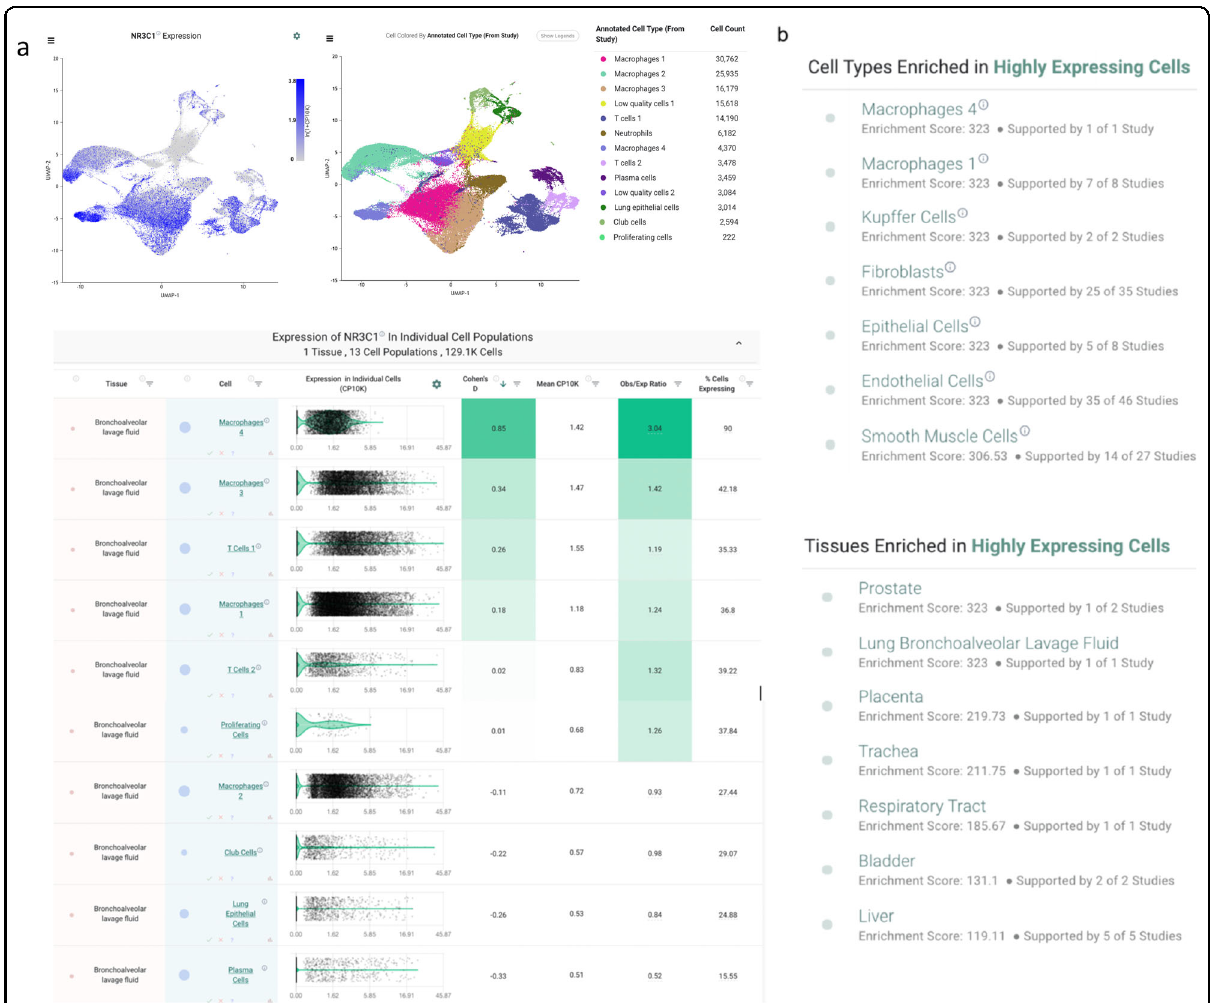
Fig. 5 Analysis of available single-cell RNA sequencing data from cells recovered from bronchoalveolar lavage fl uid of COVID-19 patients. A Expression of NR3C1 in cells from bronchoalveolar lavage fl uid (BALF) of COVID-19 patients ( n = 9; 3 mild, 6 severe) by single-cell RNA-sequencing. B Summary of IL-6/NR3C1 co-expression across 1.9 million human cells from single-cell RNA-sequencing datasets. Shown are cell and tissue types most highly enriched for detection of both NR3C1 and IL-6 in the same individual